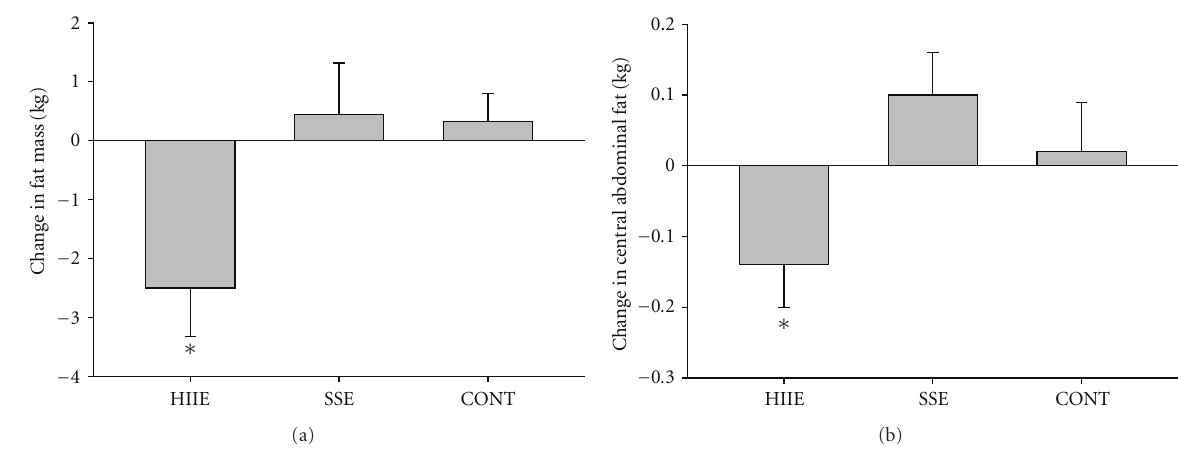
Figure 2: Subcutaneous (a) and abdominal fat loss (b) after 15 weeks of high-intensity intermittent exercise. HIIE: high-intensity intermittent exercise, SSE: steady state exercise, Cont: control. ∗ Significantly di ff erent from control and SSE groups ( P < . 05). (Adapted from Trapp et al.